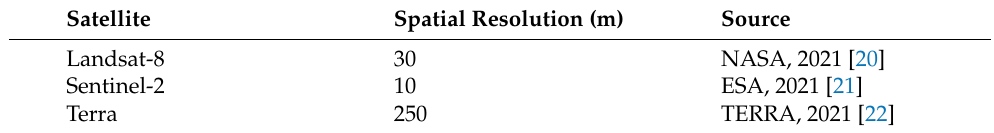
Table 1. Spatial resolution of the satellite used for automatic forest monitoring